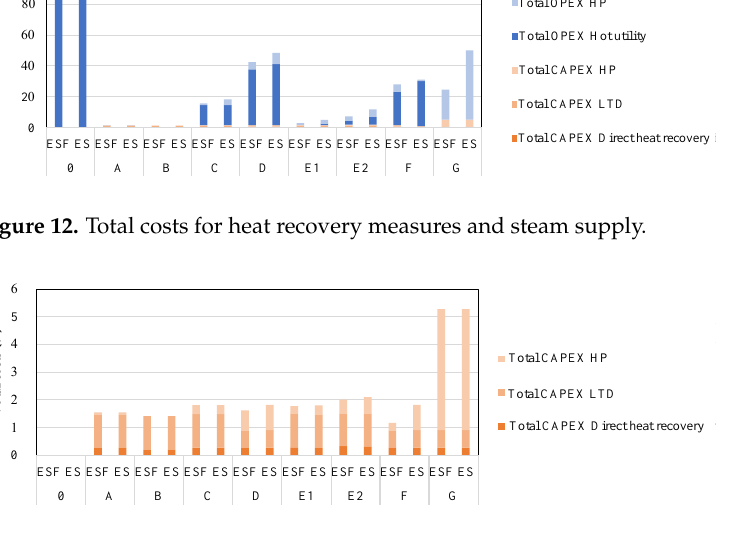
Figure 13. Total costs for heat recovery measures and steam supply—only